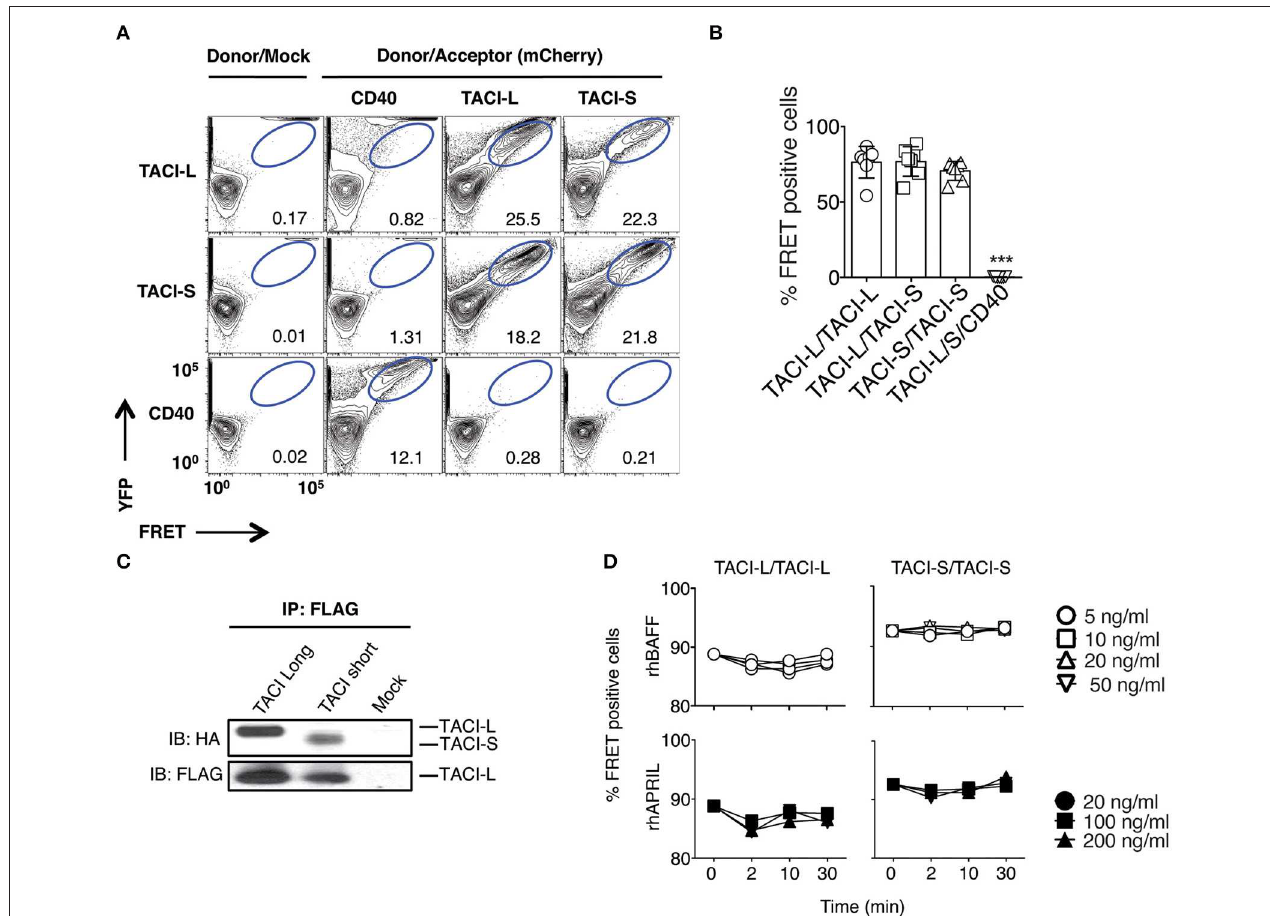
FIGURE 1 | TACI Isoforms form hybrid complexes detected by FRET. (A) To examine isoform complexes, YFP and mCherry labeled TACI-L, TACI-S, and/or CD40-eYFP as a control, were co-transfected into HEK-293T cells. After 48h, the molecular association was analyzed by FRET using FACS (LSRII). A minimum of 50,000 positive cells were examined in all experiments. The dot plot results in each panel, are shown for one sample, representative of the results for 6 different experiments. The numerical data given in each panel, are the percent of FRET positive cells, of the live cells in the gate, averaged for all 6 experiments. (B) Frequency of FRET positive cells in the double positive YFP and mCherry gate from (A) . Graph shows the mean ± SD. *** p < 0.001, two-tailed paired Student t -test of 6 independent experiments. (C) Either HA-labeled TACI-S or TACI-L transfected into HEK-293T cells, could be precipitated with TACI-L-FLAG as demonstrated in immuno-blotting using anti-HA staining. Lower panel shows FLAG expression as control. (D) Addition of increasing amounts of ligands BAFF or APRIL to the TACI-S and TACI-L complexes had no effect on the FRET signal, indicating that receptor assembly in these cells is ligand independent. Data are the mean ± SD from 3 independent